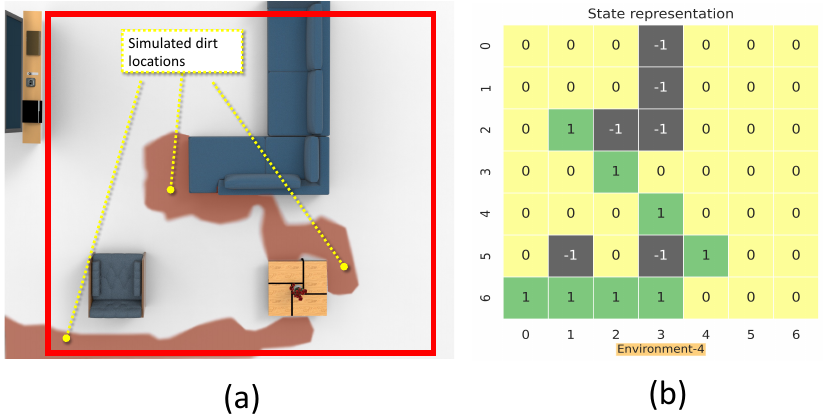
Figure 7. The simulation environment 4 ( a ), and 7 × 7 reduced environment representation ( b